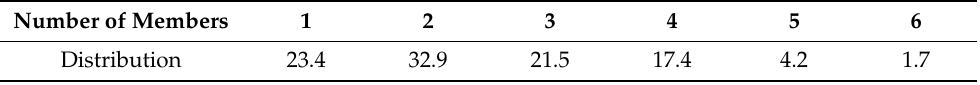
Table A1. Distribution of households according to the number of members (Source: